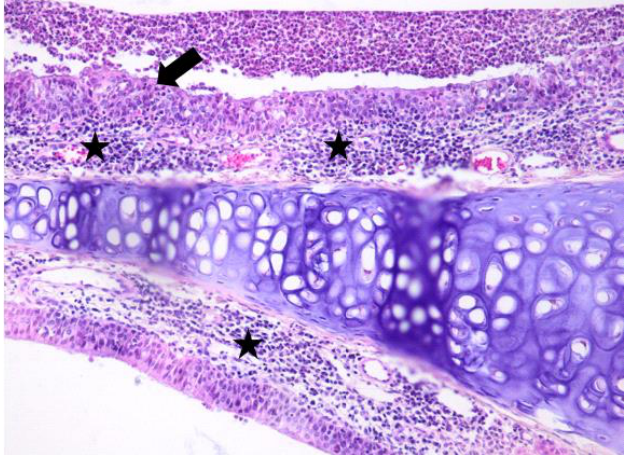
Figure 2. Light micrographs of the rat’s nasal septum, dexamethasone group, at 5 days after the intranasal intervention. The septal nasal mucosa is covered by an abundant purulent material, is focally hyperplastic, with occasional squamous metaplasia (arrow). The lamina propria is expanded and the nasal glands are replaced by lymphocytes, macrophages and plasma cells (black star). H&E, ob ×20.